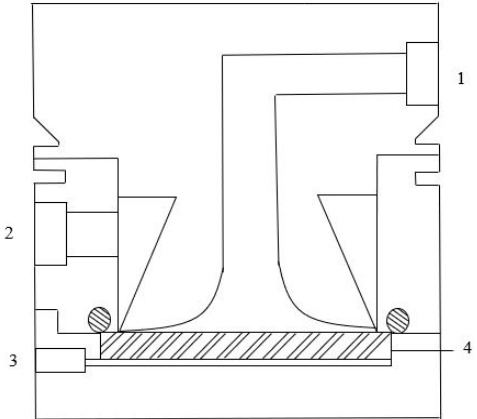
Figure 2. Cross-section of the membrane cell. 1. Feed inlet; 2. Feed outlet; 3. Permeate stream; 4. Porous stainless-steel plate (membrane support). Figure adapted from [34].